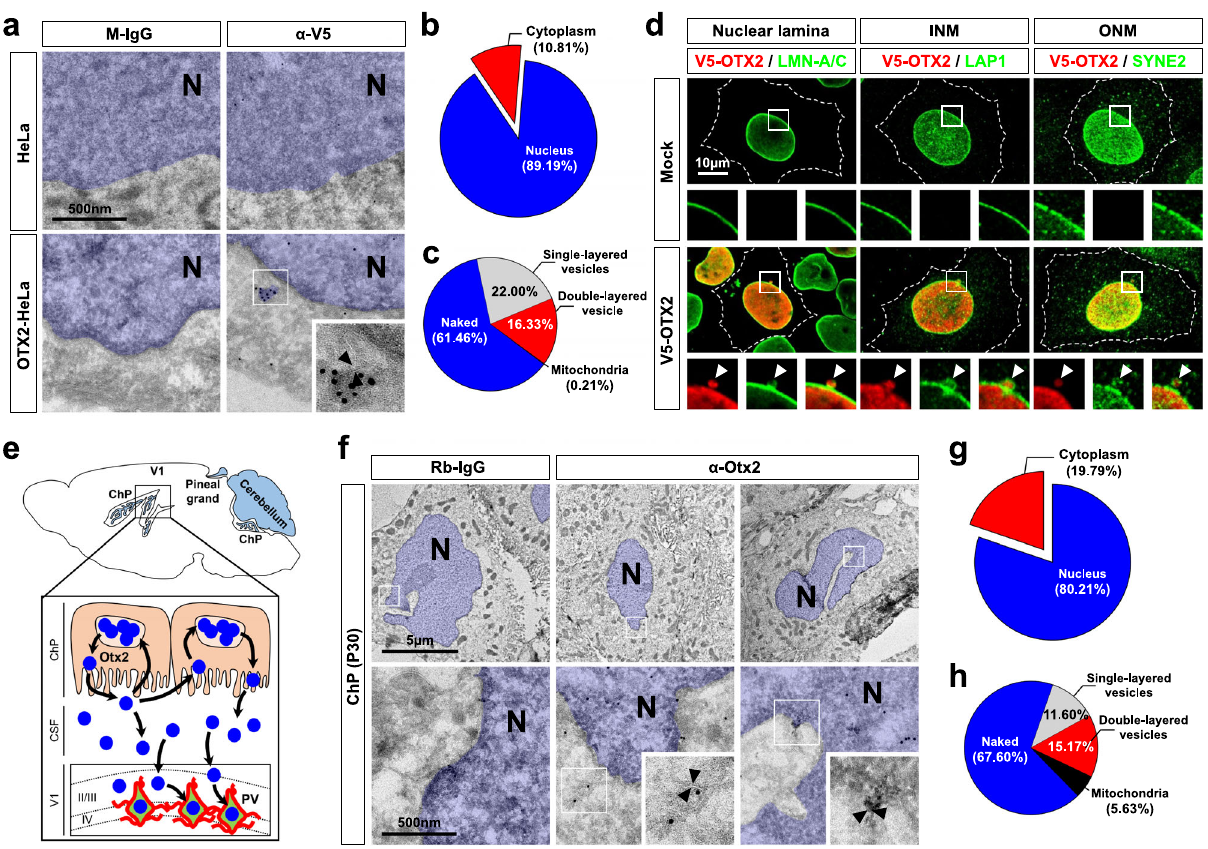
Fig.3|OTX2isdetectableindouble-layeredmembranevesicles.a Cryo-sections (50nm) of HeLa and OTX2-HeLa cells were stained with gold-labeled anti-mouse IgG that detects preimmune mouse IgG and mouse anti-V5 antibody ( α -V5) on the sections. The gold particles of anti-mouse IgG on the section are shown in black dots. The inset is magni fi ed image of the box area. Nuclear plasm (N) is pseudo- colored in blue, and nuclear membranes are pointed by with dotted arrowheads. b Pie chart shows the relative distribution of gold particles in the nuclei and cytoplasm of OTX2-HeLa cells ( n =22, from 6 independent batches). c Pie chart shows the locations of gold particles in the cytoplasm of OTX2-HeLa cells. Naked, notassociatedwithamembrane( n =22,from6independentbatches). d HeLacells transfected with Mockor V5-OTX2 werevisualized usingantibodiesagainstV5 (for OTX2), LMN-A/C (for nuclear lamina), LAP1 (for the INM), or SYNE2 (for the ONM).